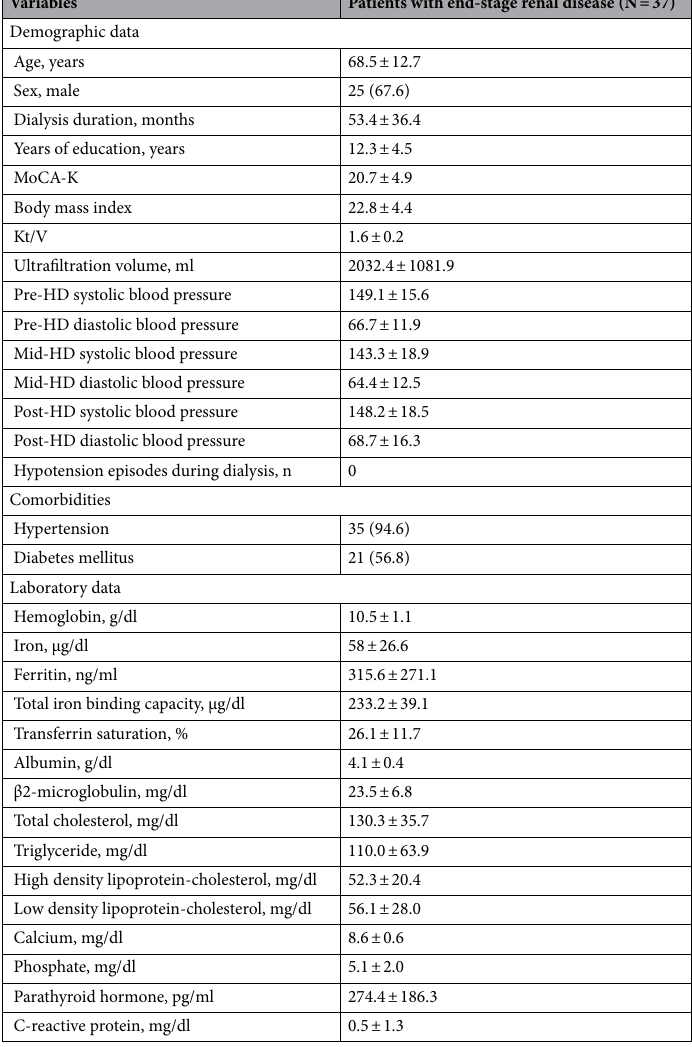
Table 1. Patients’ demographic and clinical characteristics. Data are presented as number (%) or mean ± standard deviation. MoCA-K: Korean version of Montreal Cognitive Assessment; Kt/V: Dialyzer clearance × time/distribution volume of urea; HD: